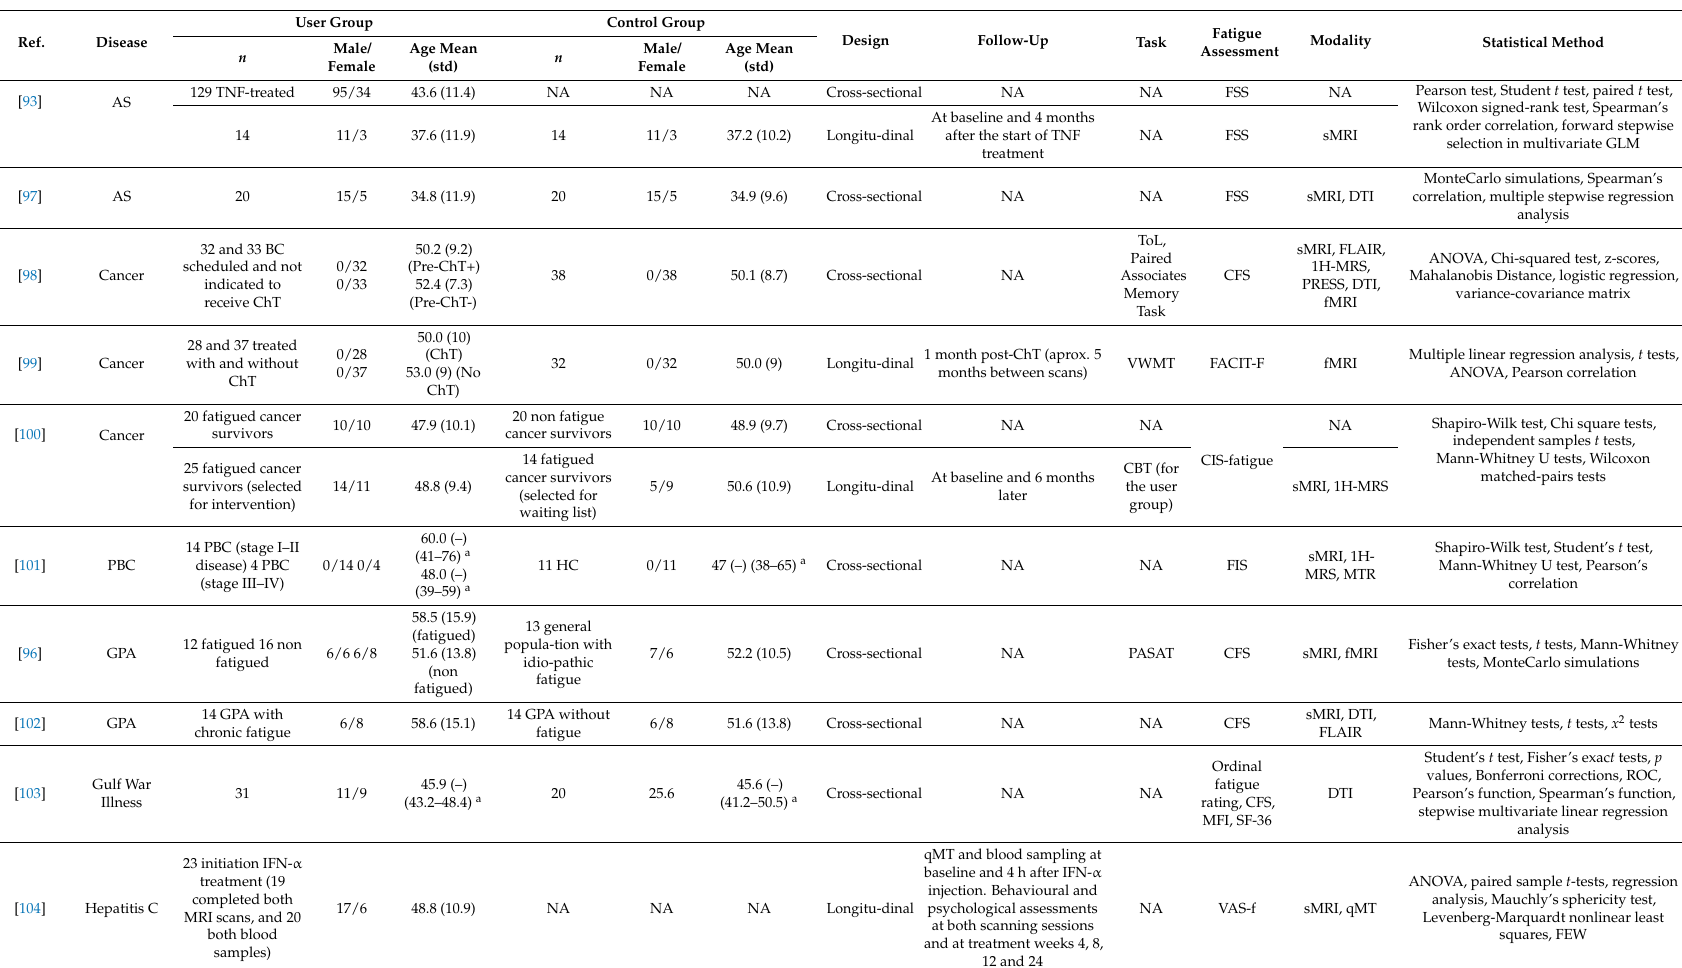
Table 1. Characteristics of included